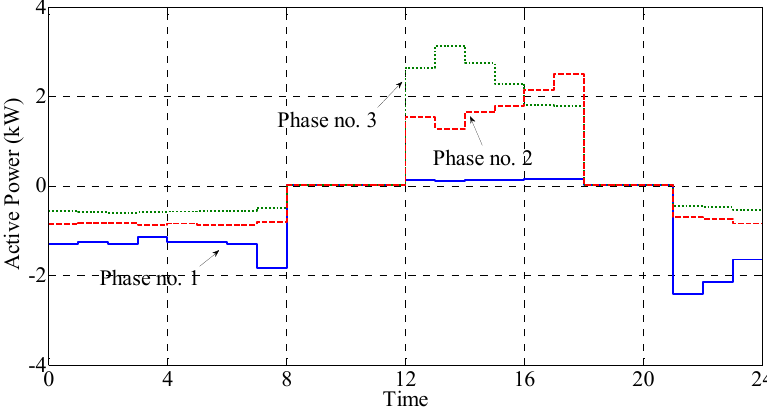
Figure 13. Case Study 3: Active power of the DESS at bus no.37 during the last typical day. Appl. Sci. 2018 , 8 , x FOR PEER REVIEW